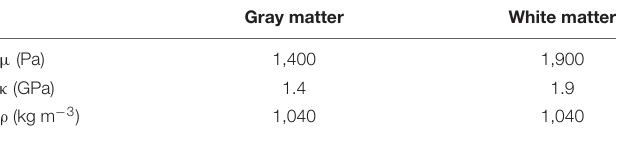
TABLE 1 | An overview of the material parameters used for mechanical simulation. Gray matter